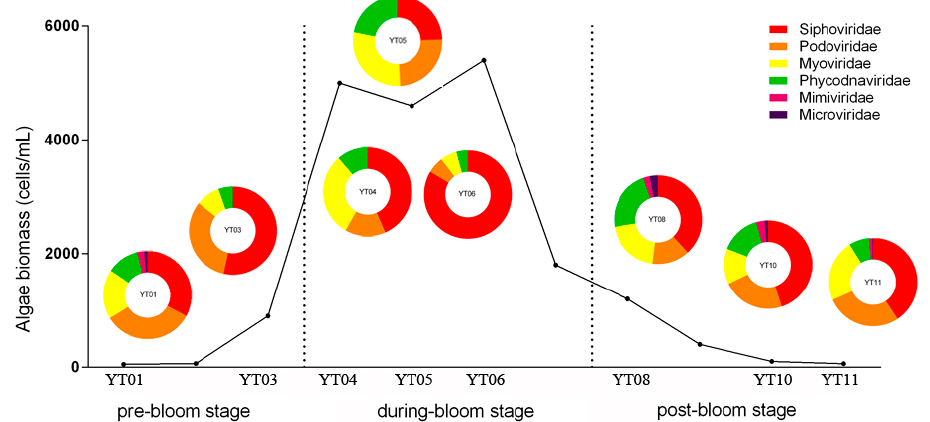
Figure 2. Taxonomic compositions of viral communities at the family level in different bloom stages. The pie charts show percent relative abundances of viral groups for all eight samples.